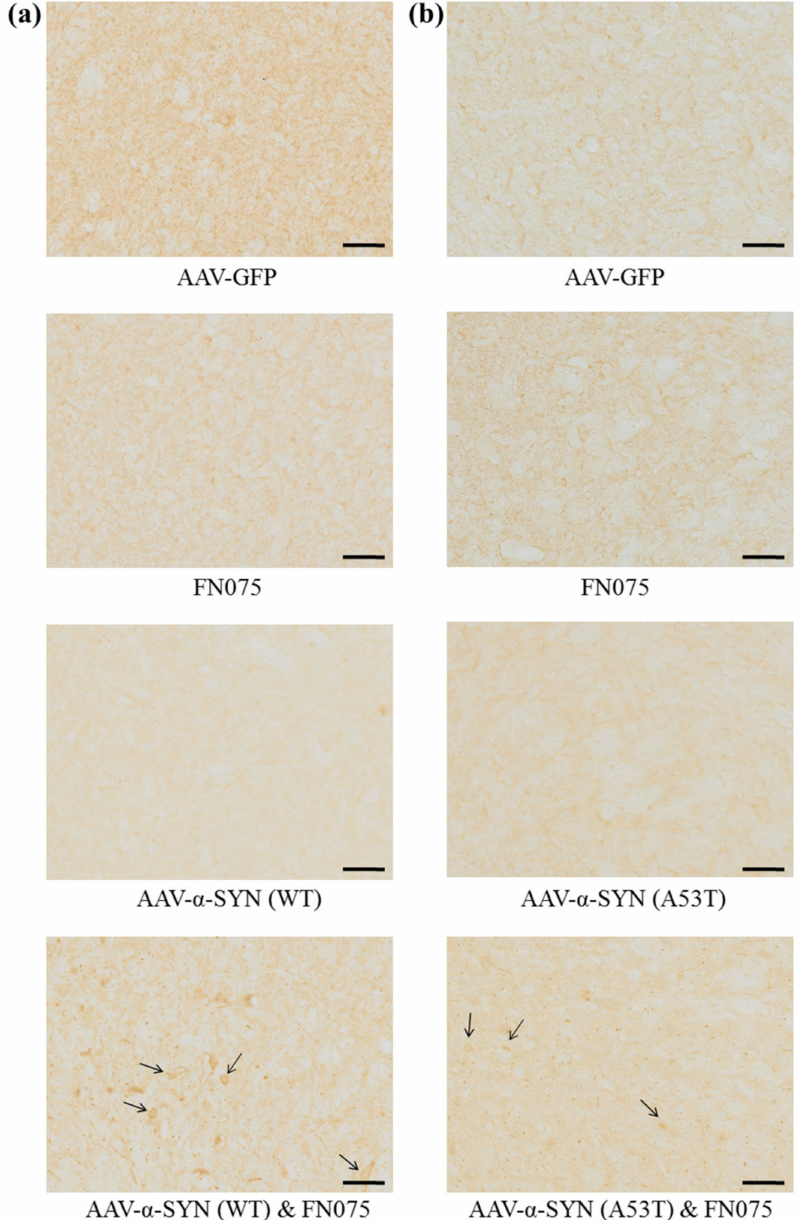
Figure 5. Immunohistological visualization of the impact of the small molecule FN075 on the expression of α -synuclein aggregates in the substantia nigra. FN075 in combination with ( a ) AAV- α - SYN (WT) or ( b ) AAV- α -SYN (A53T) induced the aggregation of α -synuclein in the substantia nigra on the ipsilesional side. Scale bars represent 50 µ